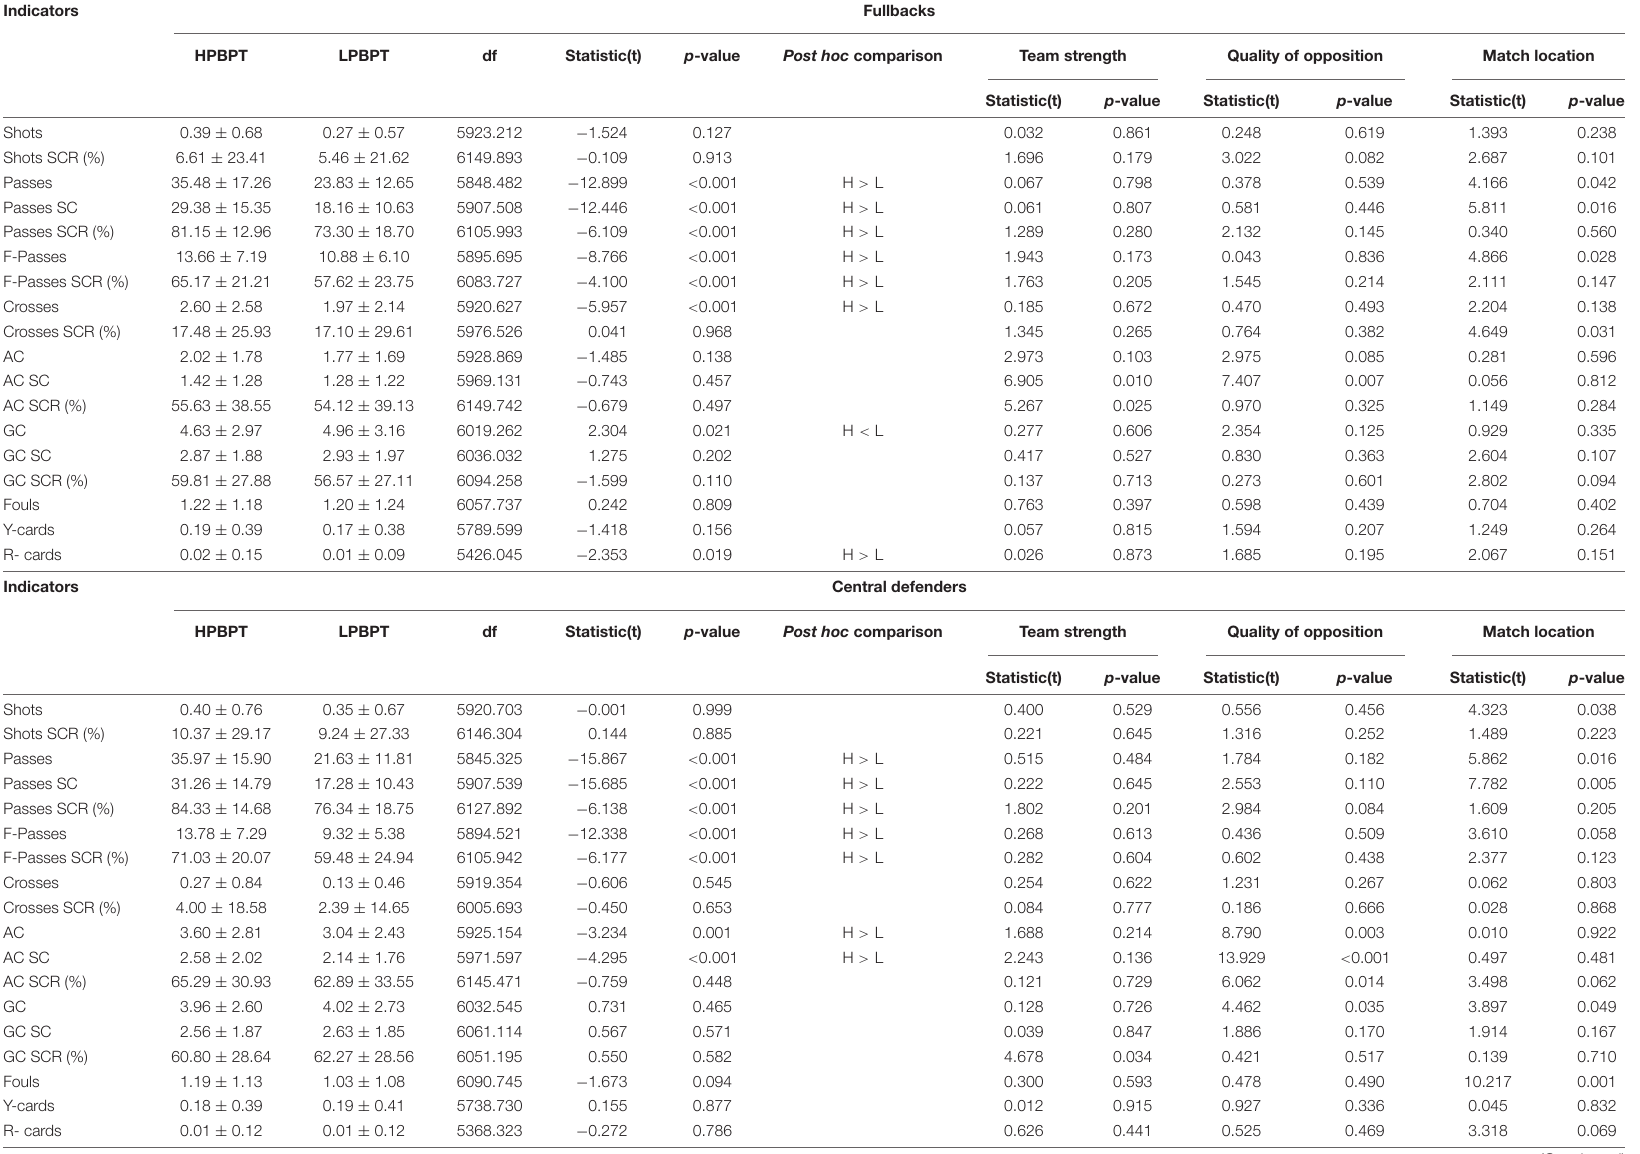
TABLE 5 | Technical and tactical performance in terms of playing position between HPBPT and LPBPT.